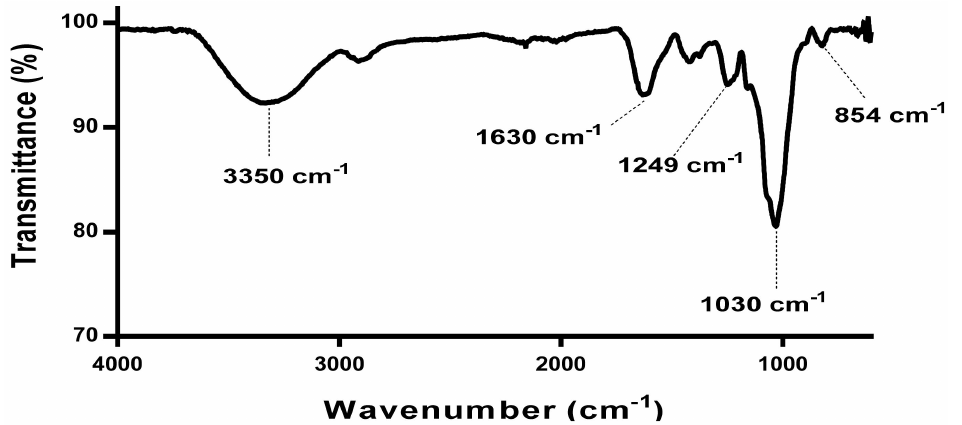
Figure 1. Fourier transform infrared spectra analysis of E. radiata fucoidan. The annotated peaks are representative of fucoidan structure reported in the